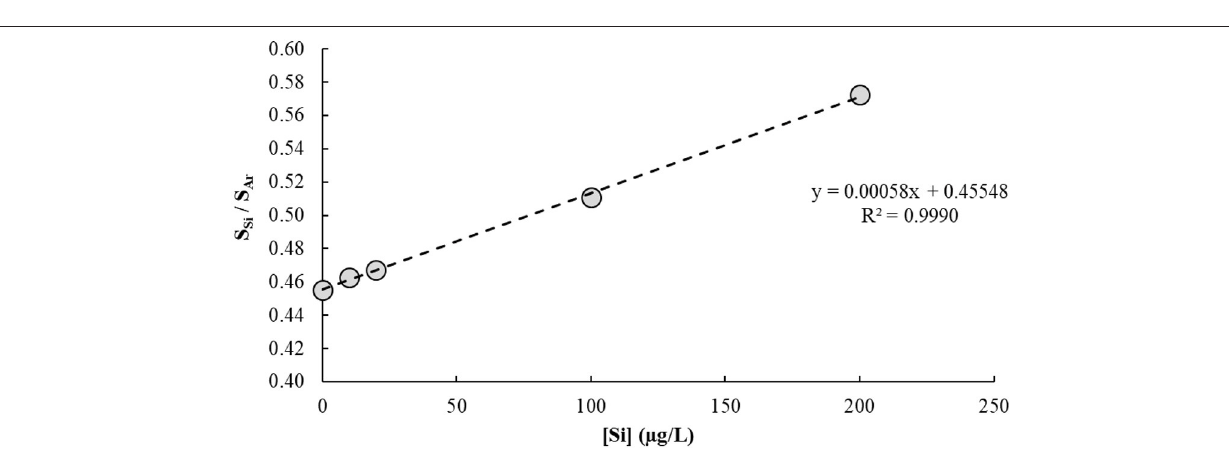
FIGURE 3 | Calibration plot used to determine Si in a 1% v/v HNO 3 matrix by ICP-QMS ( m/z = 28) using the IFS method. The 38 Ar + ion was used as IFS species, and the analyte-to-IFS signal ratio was plotted on the y -axis. No collision/reaction gas was used.